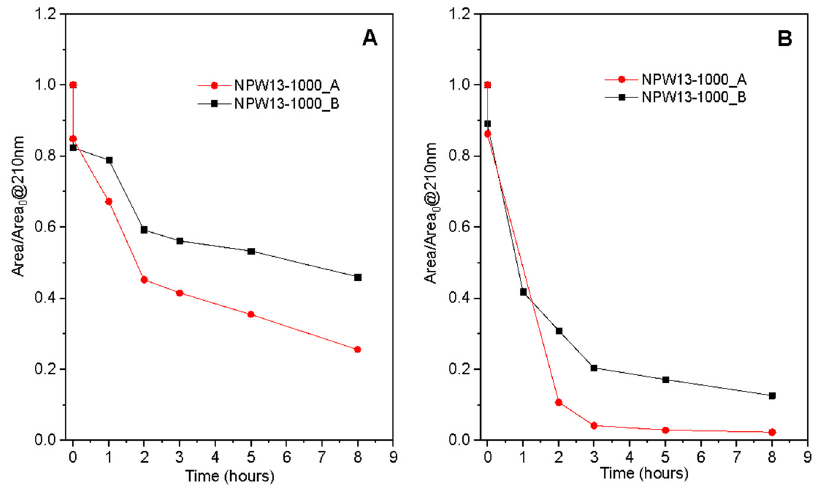
Figure 10. Difference in the performances of BPA degradation at ambient T and at 70 °C of two NPW13-1000 powders prepared following the same procedure but in two different laboratories (Lab A and Lab B).